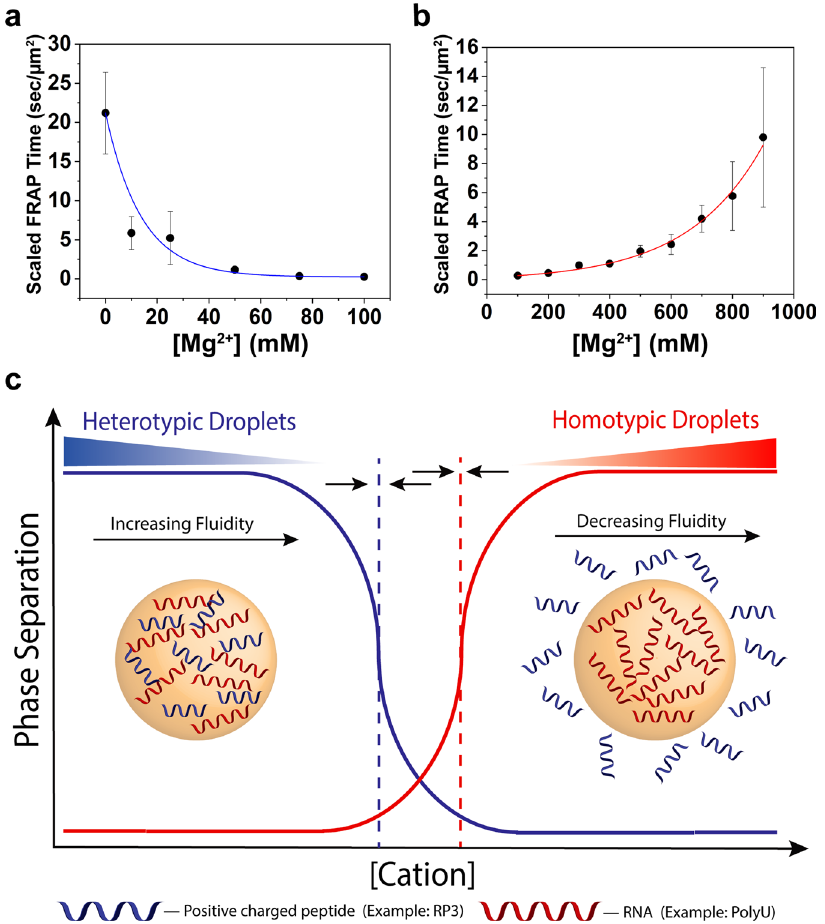
Figure 4. Magnesium concentration alters the fluidity of heterotypic and homotypic droplets. ( a ) Scaled FRAP in heterotypic RP3-polyU droplets as a function of [MgCl 2 ]. ([RP3] = 500 μ M, 0.6x polyU wt/wt) The blue line is a visual guide. ( b ) Scaled FRAP in homotypic polyU droplets as a function of [MgCl 2 ]. (2 mg/mL polyU, 10% PEG) The red line is a visual guide. ( c ) Cartoon representation of switch-like behavior between heterotypic and homotypic droplets as a function of increasing cation concentration. The dotted lines represent the phase boundaries of the distinct droplet types. The arrows indicate that these phase boundaries will move under changing conditions and are capable of